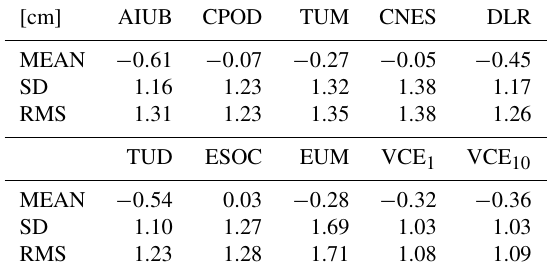
Table 6. SLR validation of individual solutions and the combined orbit by using